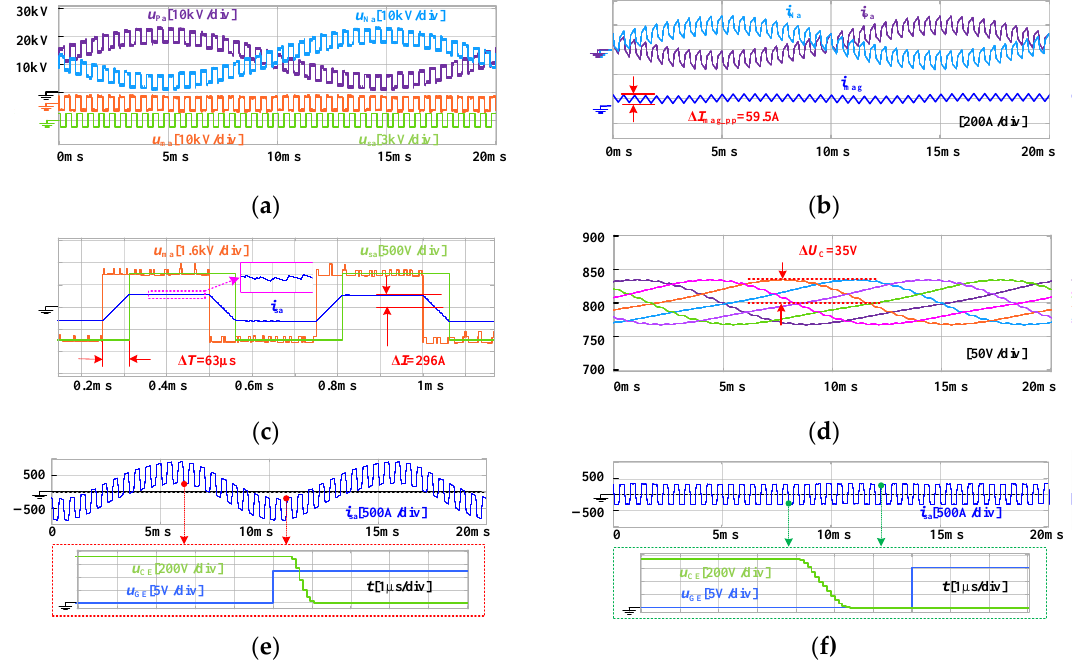
Figure 8. Steady-state simulation results: ( a ) arm voltages and transformer winding voltages; ( b ) arm currents and magnetizing current; ( c ) transformer winding voltages and secondary winding current; ( d ) six arm SM voltages; ( e ) secondary winding current with double LF fluctuation; ( f ) secondary winding HF current after applying the proposed modulation.